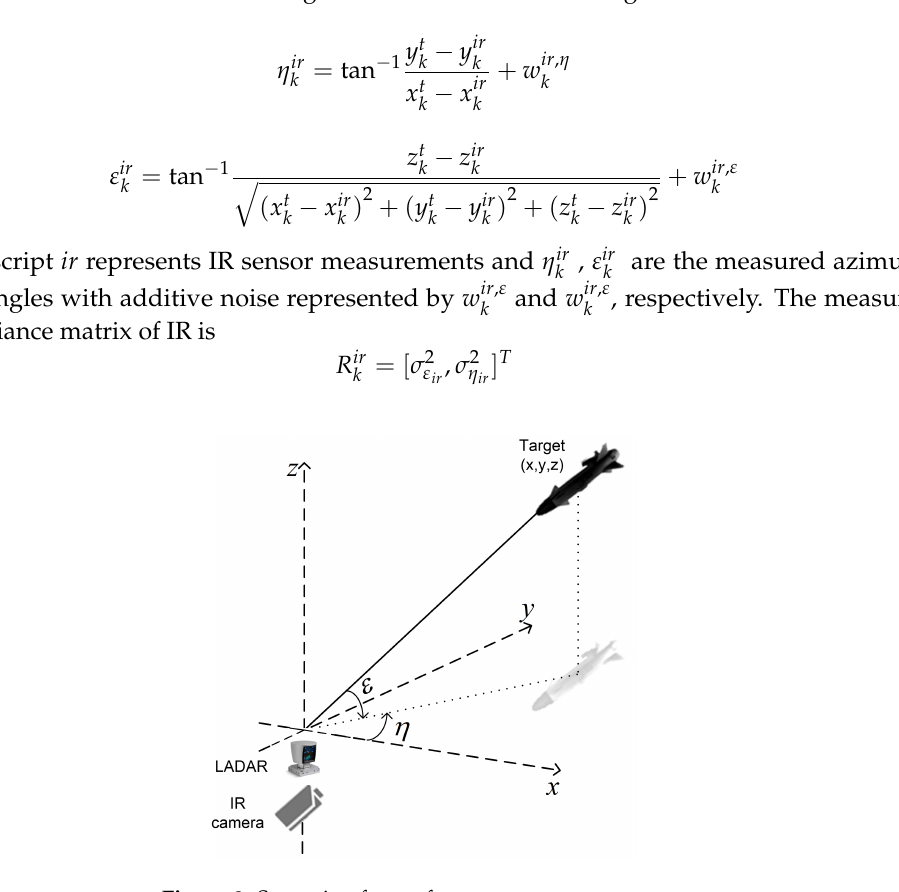
Figure 3. Scenario of out-of-sequence